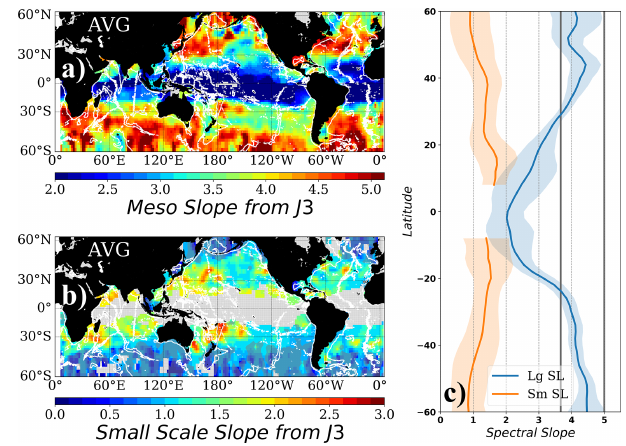
Figure 5. Same as Fig. 4 for Sentinel-3: (a) mesoscale and (b) small-scale spectral slopes fitted to the observed unbiased PSD from Sentinel-3A. (c) Zonal average of the mesoscale (Lg SL) and small-scale (Sm SL) spectral slopes in (a) and (b) . Color shading around the average values corresponds to the 95% confidence in- terval for the zonal mean. Vertical gray lines denote the k − 11 / 3 and k − 5 spectral slope values. Gray shading in (b) corresponds to zones where the uncertainty associated with the slope estimate is higher than 40% of the slope value. Blank areas in (b) correspond to zones where the double-slope model does not describe the ob- served shape of the spectrum. Dashed gray lines in (c) correspond to Jason-3 zonal averages from Fig. 4c. White contours represent the topography at 3000m